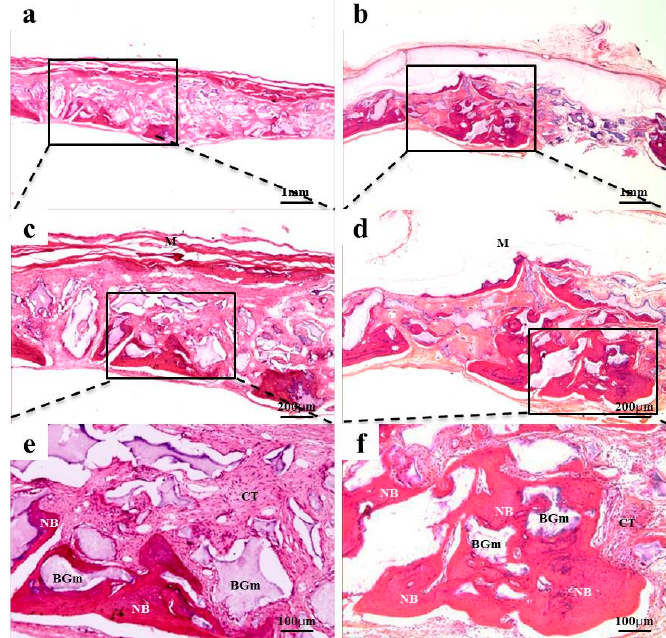
Figure 5. Collagen membrane and 0.10 mm BC membrane. Histological sections of defect sites at 8 weeks after surgery: ( a , c , e ) collagen membrane; ( b , d , f ) 0.10 mm BC. New bone formations were observed in all groups. NB, Fibrous connective tissue; M, membrane; CT, connective tissue; BGm, bone grafting material. Original magnification: ×20 (a,b), ×40 (c,d), ×100 (e,f).